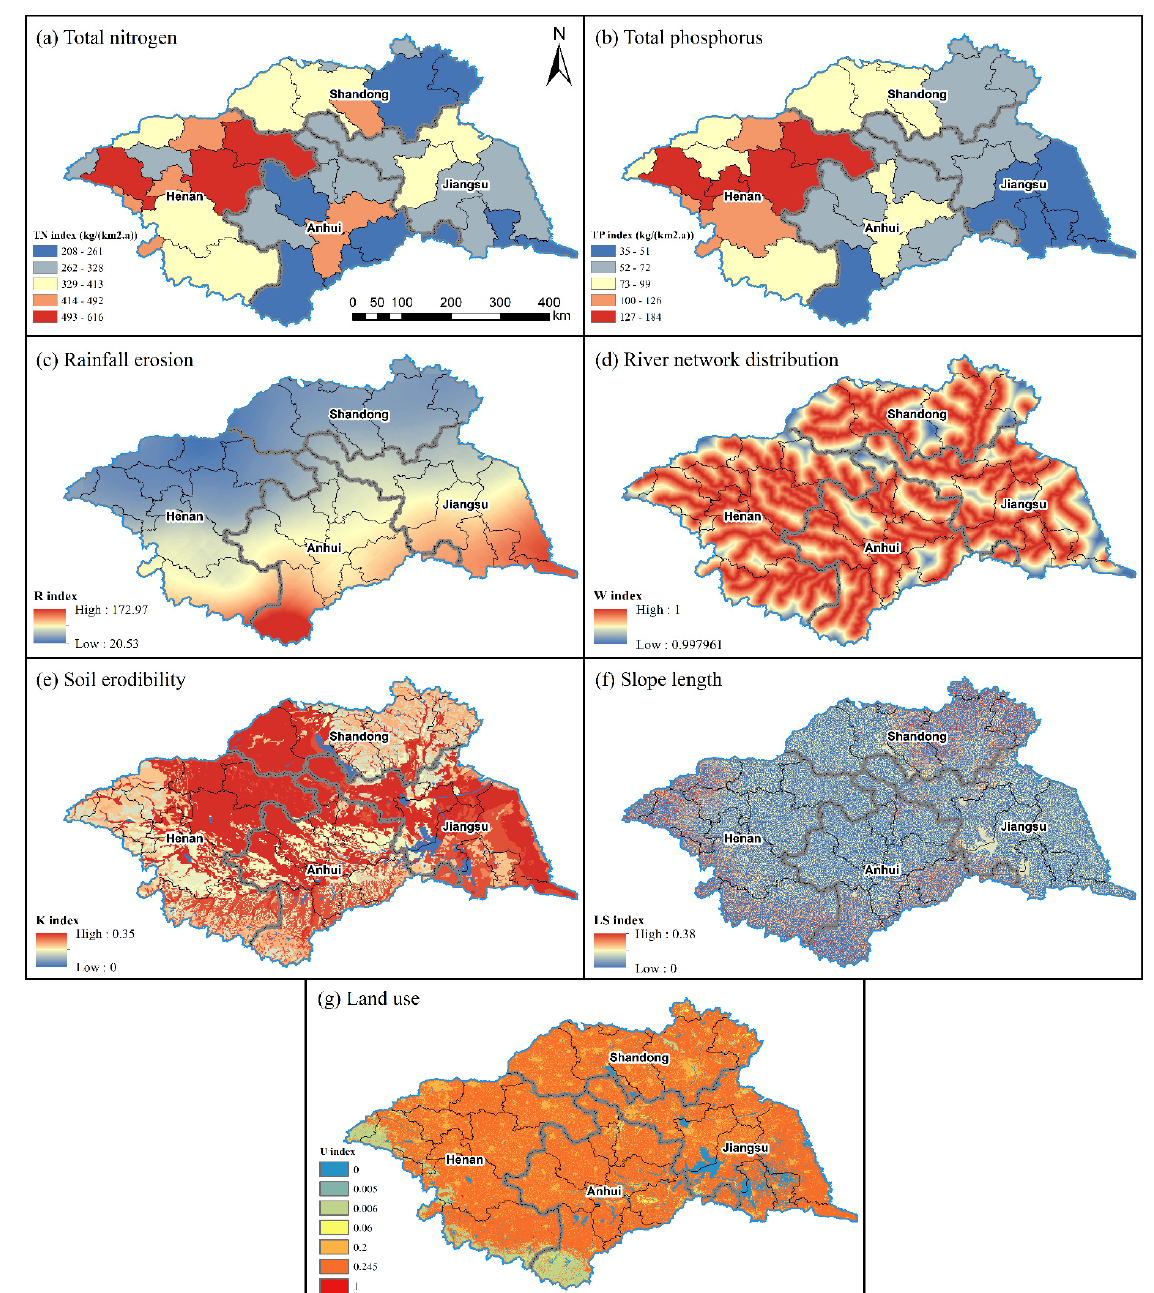
Figure 4. Spatial distribution of total nitrogen ( a ), total phosphorus ( b ), rainfall erosion ( c ), river network distribution ( d ), soil erodibility ( e ), slope length ( f ), and land use ( g ) factors in HRB.